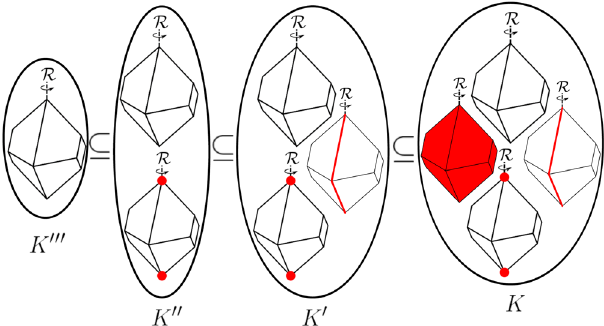
FIG. 2. The bulk classifying group K classifies all bulk phases, regardless of the existence or type of anomalous boundary states. Refined classification groups K ð n Þ are obtained by excluding topological phases with anomalous boundary states of codimen- sions ≤ n . The figure illustrates this procedure for a crystal with a twofold rotation symmetry R . Anomalous boundary states are indicated in